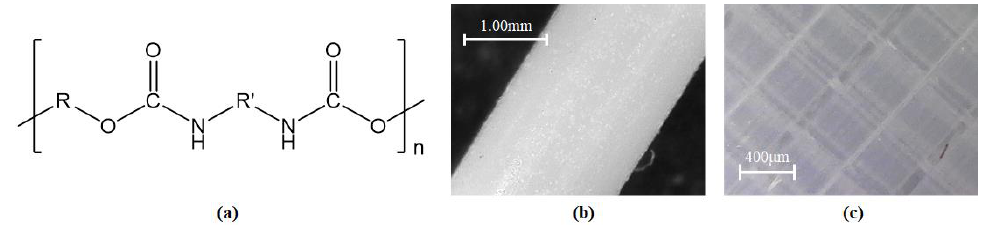
Figure 12. TPU ( a ) chemical structure; ( b ) raw material; and ( c ) final processed material.